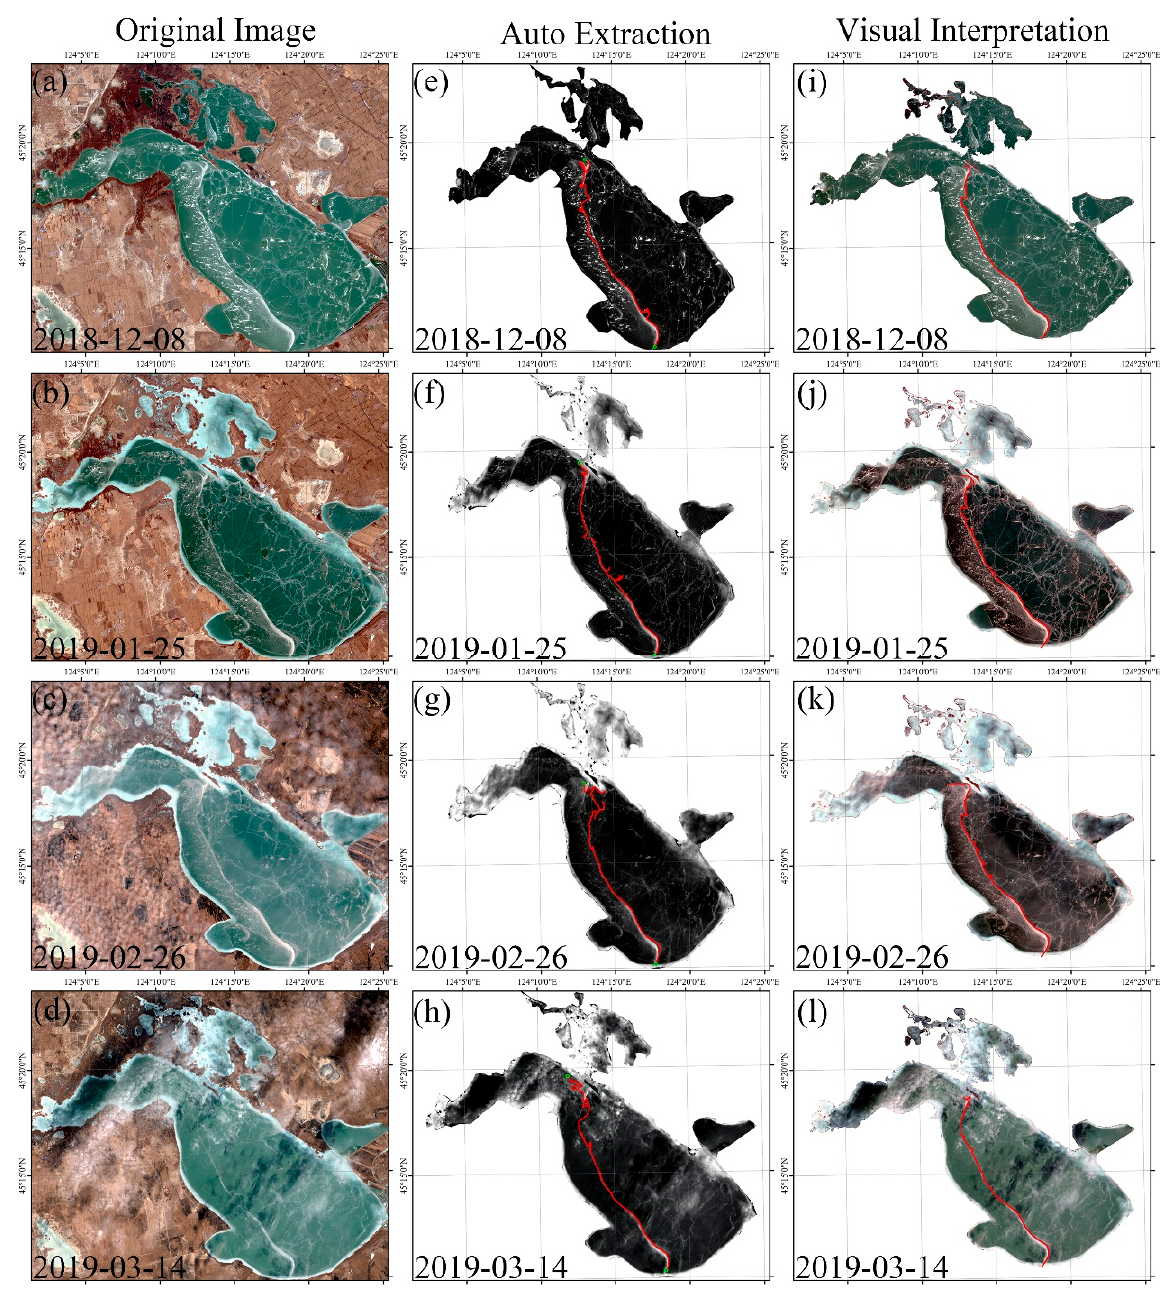
Figure 6. The lake ice cracks of Landsat OLI original images ( a – d ),auto-extraction results ( e – h ) and visual interpretation ( i – l ) of four satellite images during the cold season from December 2018 to March 2019.